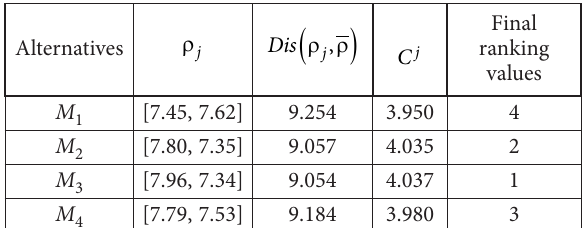
Table 9. Ranking of the alternatives